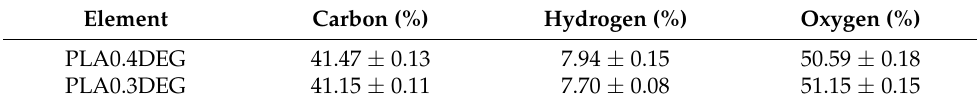
Table 3. Results of elemental analysis of new eco-polyols based on waste PLA.